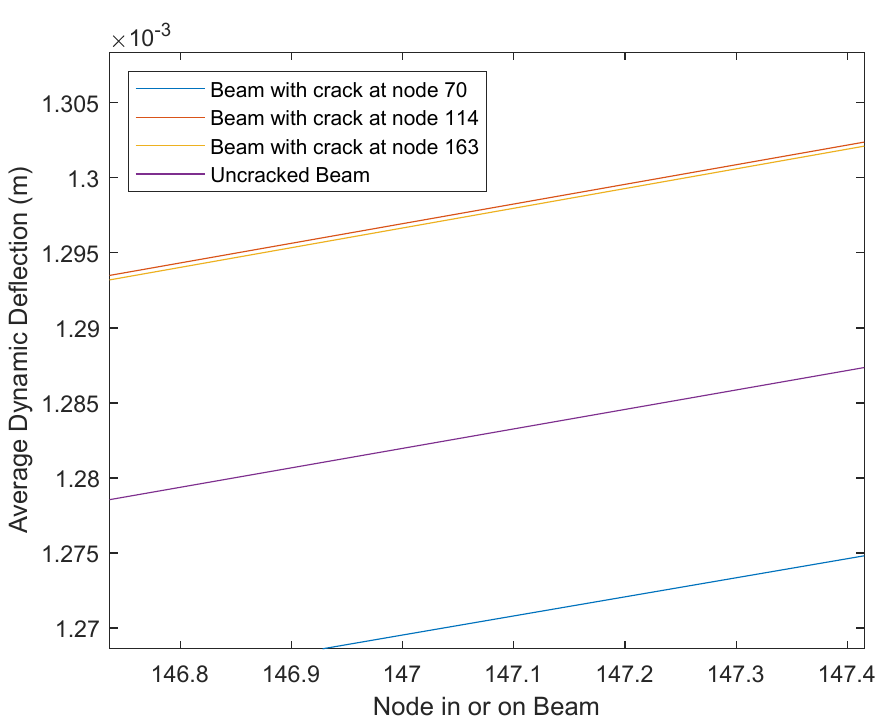
Figure 13. Blown-up view showing clearly the non-overlapping nature of the curves in Figure 12.